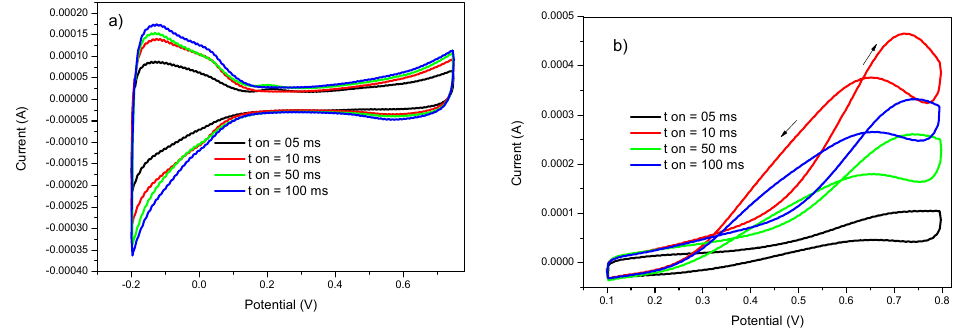
Figure 5. Cyclic voltammetry in ( a ) 0.5 M H 2 SO 4 and in ( b ) 2 M methanol +0.5 M H 2 SO 4 of GC/PANI(CV)/PtNPs electrodes obtained at various pulse widths (t on ) = 05, 10, 50, and 100 ms.